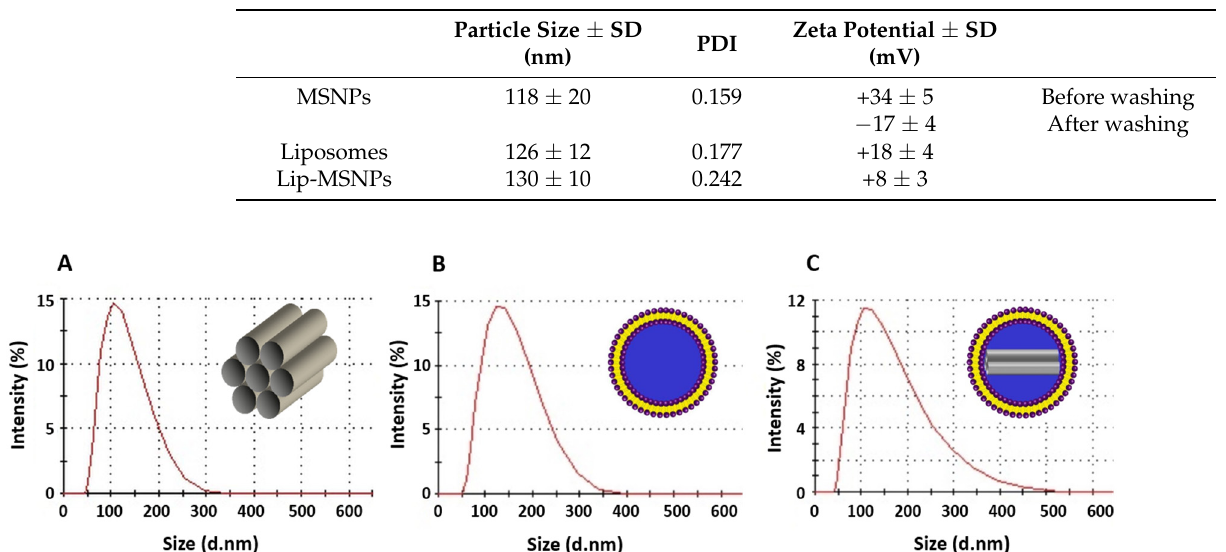
Table 1. Particle size, polydispersibility index (PDI), and zeta potential of MSNPs, liposomes and Lip-MSNPs by DLS.